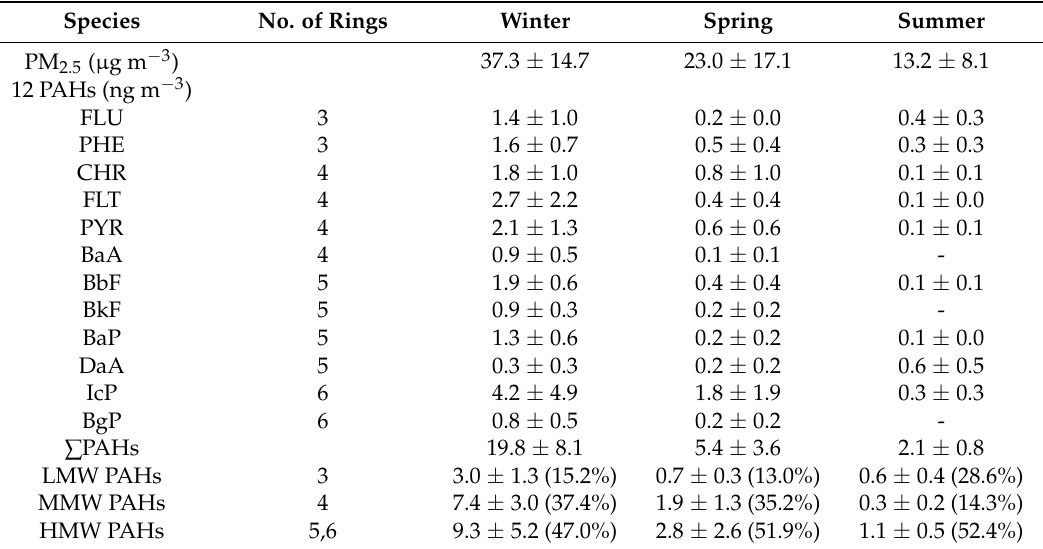
Table 6. Seasonal variation of PAH species. Note that the percentage in parentheses indicates the fraction of LMW, MMW, or HMW PAHs in ∑